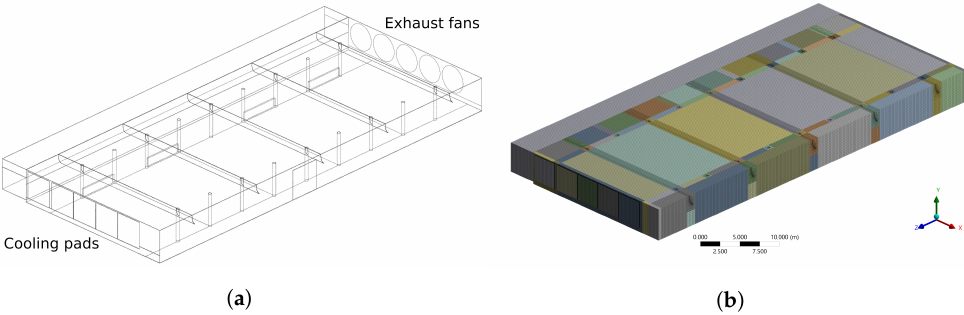
Figure 4. Model ( a ) and meshing ( b ) of the dairy cattle barn in the ANSYS CFX ®